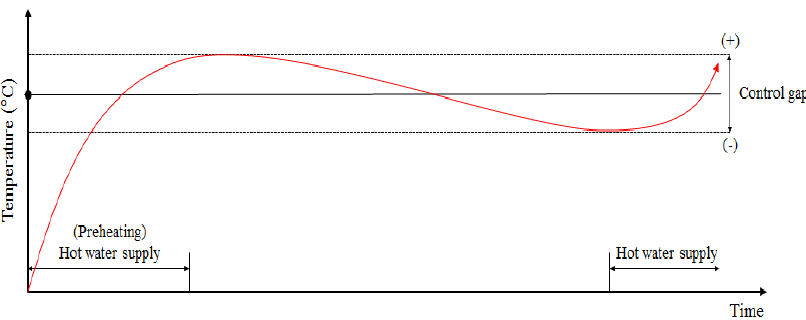
Figure 3. Hot water supply over time for a floor heating system with a PCM.